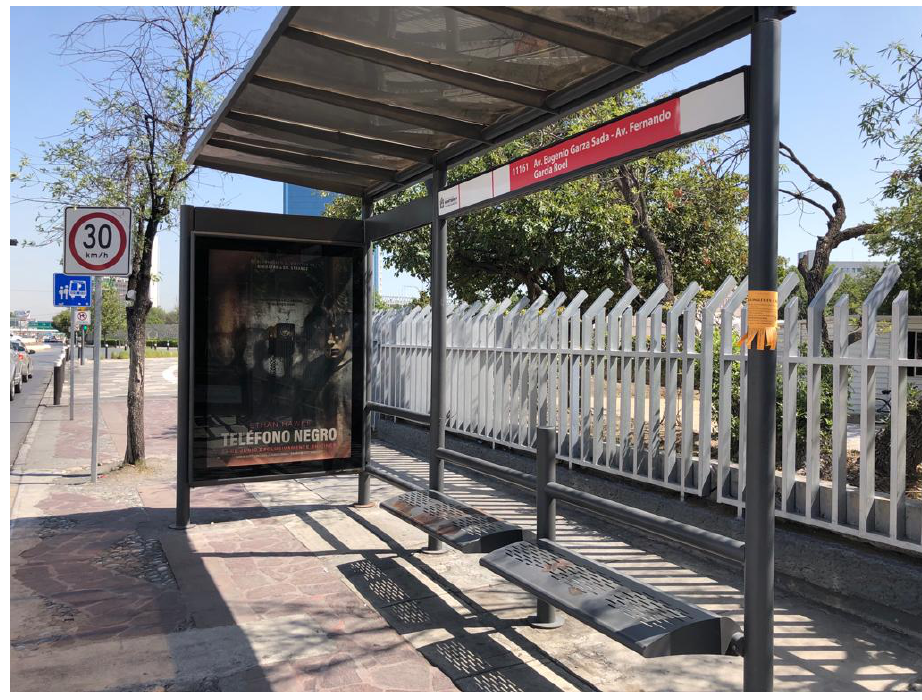
Figure 6. Full bus stop configuration in